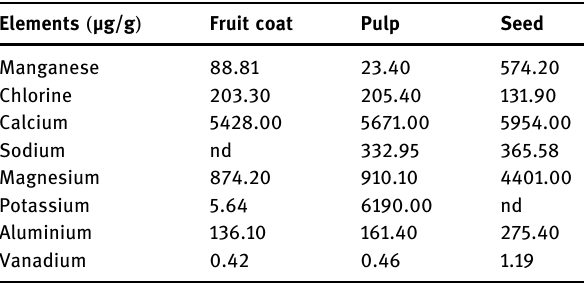
Table 3: Mineral characteristics of di ff erent parts of D.